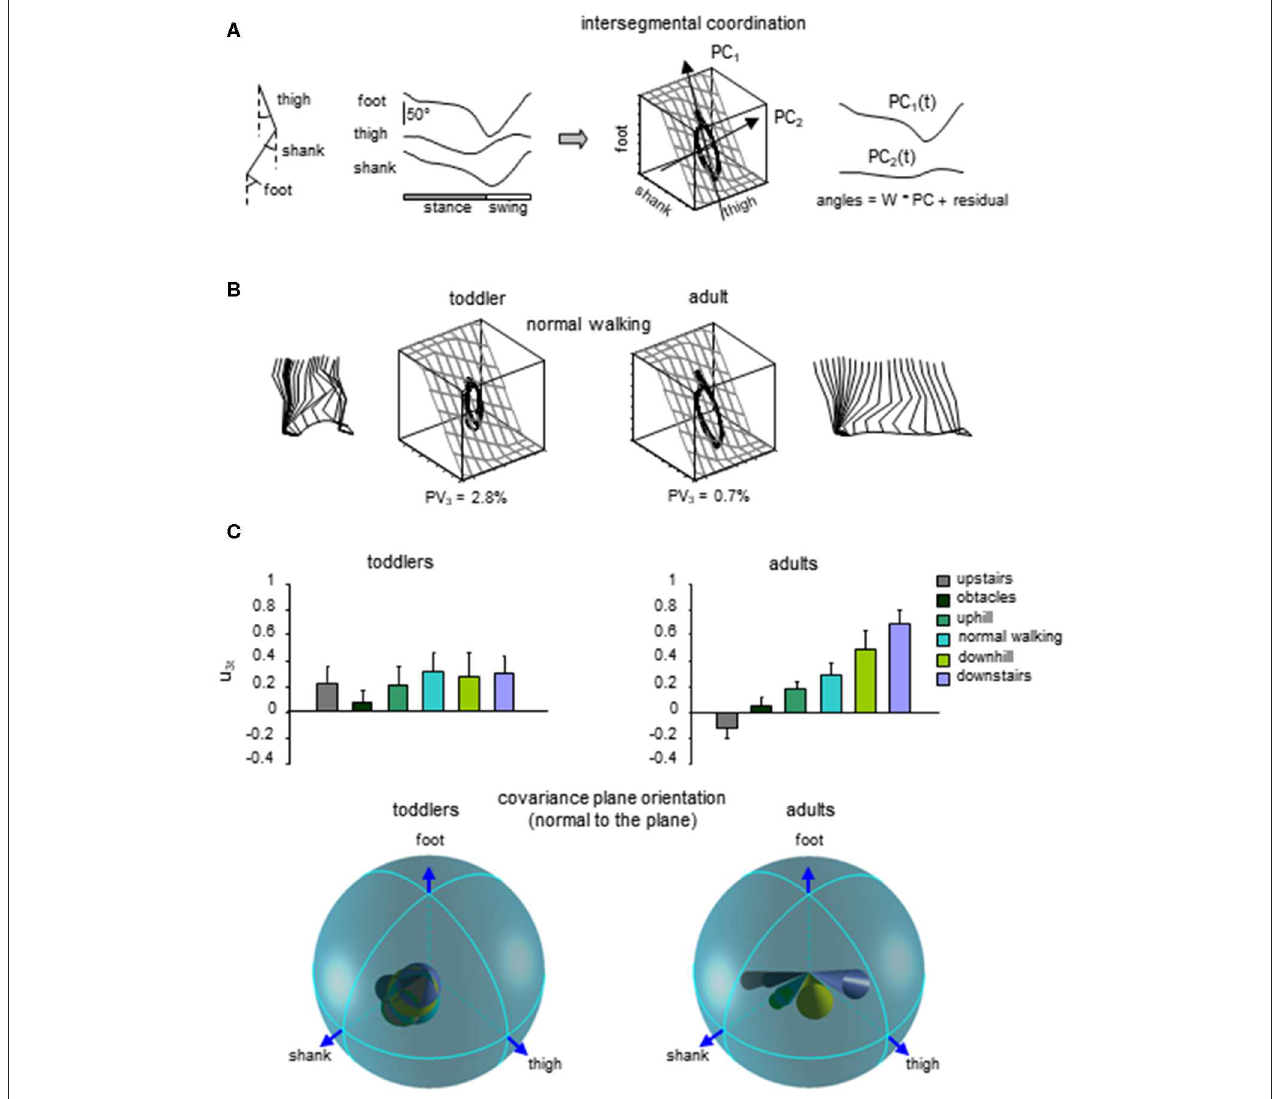
FIGURE 5 | Lack of adaptability of the intersegmental coordination to different locomotor conditions in toddlers. (A) intersegmental coordination assessed by principal component analysis (PCA) of limb segment elevation angles during walking. From left to right: thigh, shank, and foot elevation angles (relative to the vertical), corresponding 3D trajectory in segment angle space along with the interpolated plane and the directions of PC 1 and PC 2 , and two principal components that account for ∼ 99% of variance of three elevation angles in adults (modified from Ivanenko et al., 2008b). (B) examples of gait loops and interpolation planes during walking in one toddler and one adult. Stick diagrams for one stride are also shown. Percent of variance explained by the third PC (PV 3 ) is indicated, and reflects the deviation from planarity. (C) changes in the orientation of the covariance plane during walking over different surfaces in adults and a lack of these adaptations in toddlers. Upper panels: projection of the normal to the covariance plane onto the thigh axis (u 3t , mean + SD). Lower panels: spatial distribution of the normal to the plane (u 3 , the angles of cones correspond to 2 spherical angular dispersions) for each condition (modified from Dominici et al.,